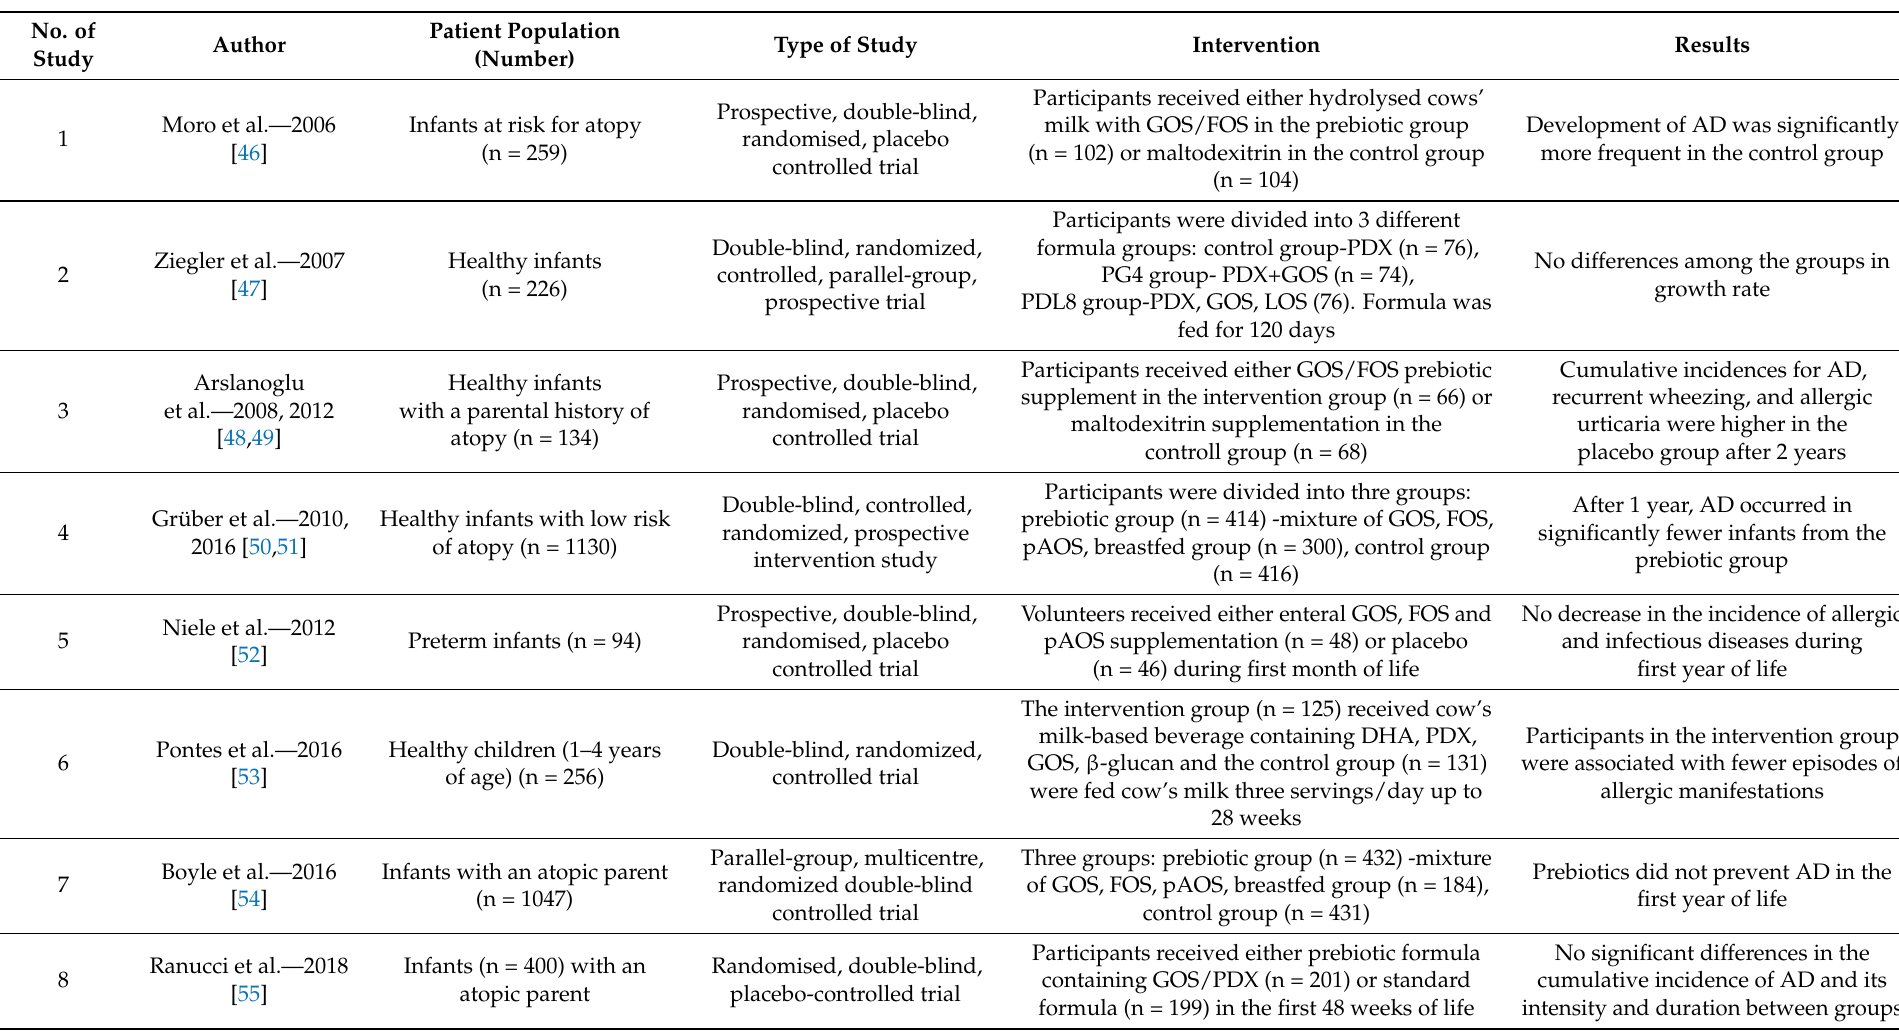
Table 2. Prebiotics in the prevention of